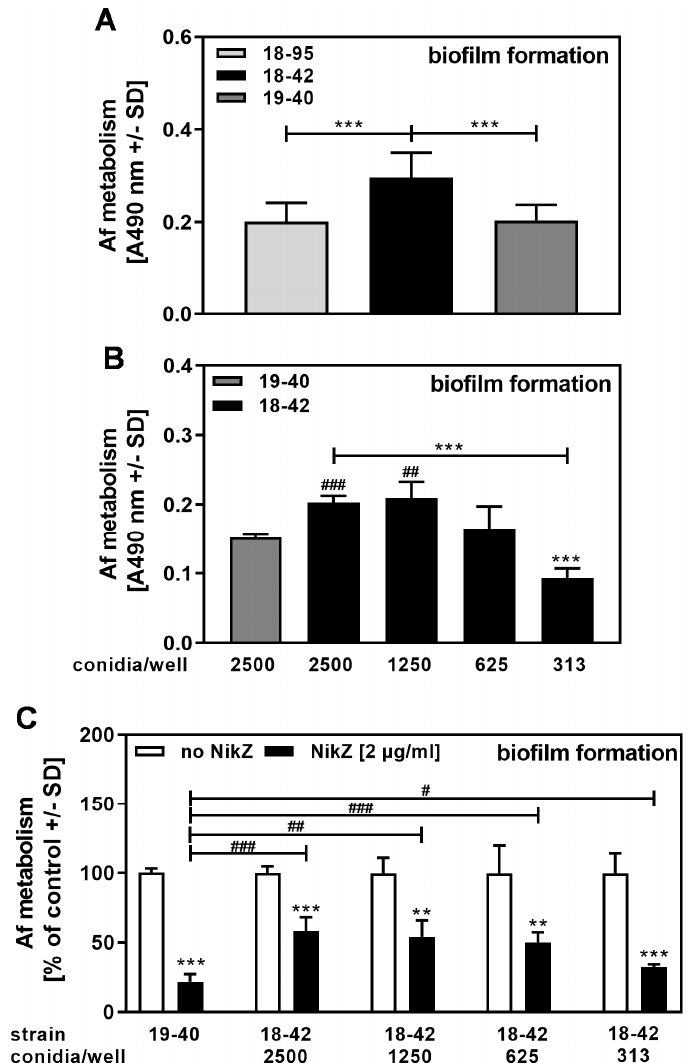
Figure 7. Increased growth does not explain decreased sensitivity of virus-free Aspergillus to NikZ. ( A ) Infected (18–95, 19–40) or virus-free (18–42) Aspergillus- forming biofilm was incubated at 37 °C for 16 h. Fungal metabolism was measured by XTT assay and is presented as A490 nm. Comparisons as indicated by the ends of the brackets. Statistical analysis (n = 12): Unpaired t -test. Three asterisks = p ≤ 0.001. ( B ) Infected (19–40) or virus-free (18–42) Aspergillus- forming biofilm was used, starting from 2500 per well. For 18–42, two-fold dilution steps were added. The assay was incubated at 37 °C for 16 h. Fungal metabolism was measured by XTT assay and is presented as A490 nm. Comparisons: 19–40 (grey bar, 2500 conidia per well) vs. 18–42 (black bars, conidia dilutions), or as indicated by the ends of the bracket. Statistical analysis (n = 4): Unpaired t -test. Two or three asterisks or pound signs = p ≤ 0.01, p ≤ 0.001, respectively. Only significant differences are indicated. Asterisks represent decreases, pound signs represent increases in fungal metabolism. ( C ) Infected (19–40, 2500 conidia/well) or virus-free (18–42, 2500 conidia per well, and 2-fold dilution steps) Aspergillus- forming biofilm was incubated with NikZ (2 µg/mL). The assay was incubated at 37 °C for 16 h. Fungal metabolism was measured by XTT assay. Metabolism in the presence of RPMI alone (white bars for each pair) was regarded as 100%. Comparisons: RPMI (white bar) vs. NikZ (black bars) for each pair, or as indicated by the ends of the bracket. Statistical analysis (n = 4): unpaired t -test. One, two, or three asterisks or pound signs = p ≤ 0.05, p ≤ 0.01, p ≤ 0.001, respectively. Asterisks represent decreases, pound signs represent increases in fungal metabolism.